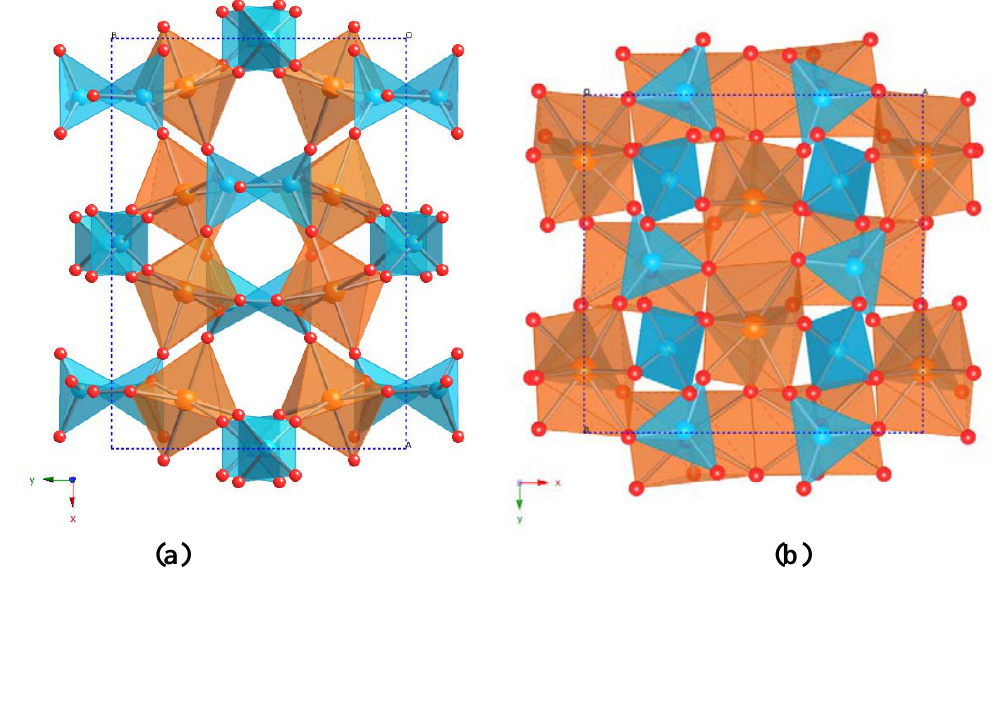
Figure 3. Crystal structures of the (a) Pbcn and (b) Pba2 polymorphs of Y down the z axis. Blue tetrahedra are MoO coordinate yttrium,